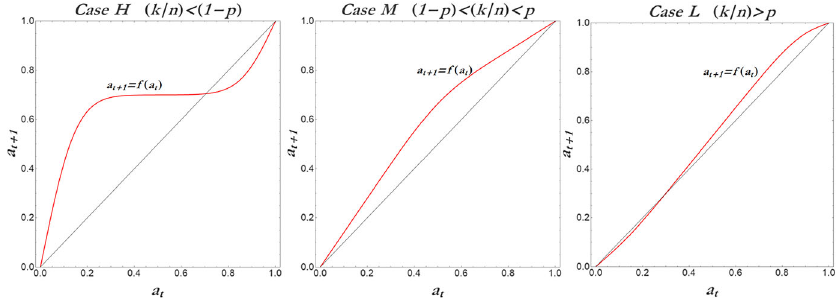
Fig. 1 Three phase diagrams are plotted with n = 20 and P A = 0 . 7. The parameter k varies: with k = 17 in case L , with k = 10 in Case M ; and k = 3 in Case